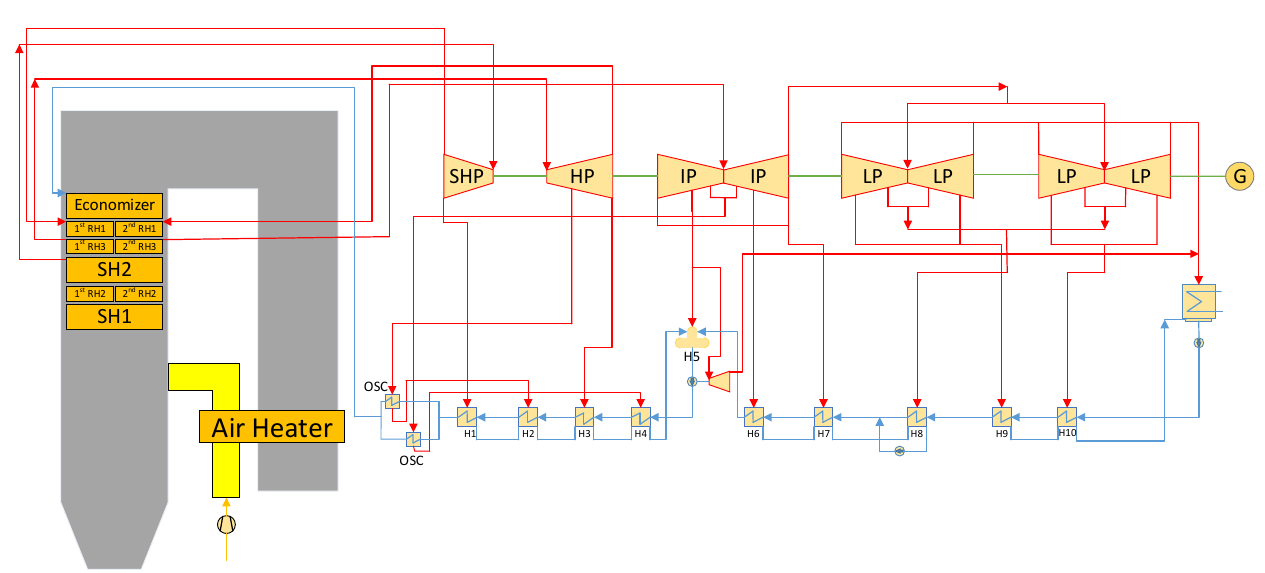
Figure 1. Flowchart of the reference double reheat coal-fired power generation system.